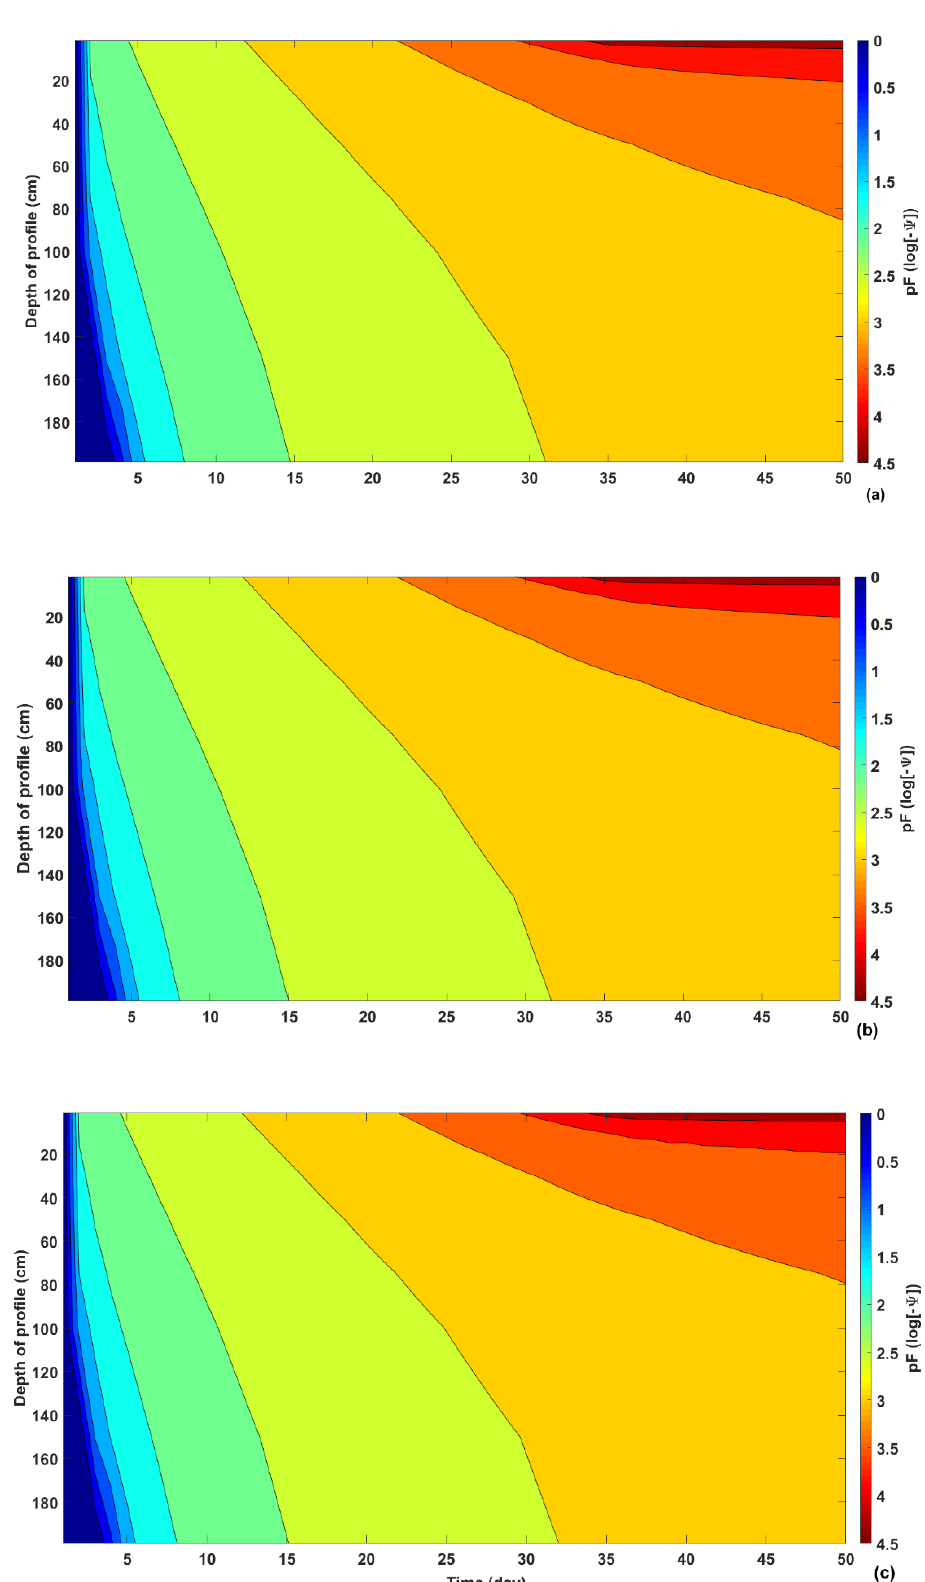
Figure 6. The simulated water potentials of the bauxite residue in a storage facility with initial water potentials of ( a ) − 1 kPa, ( b ) − 2 kPa and ( c ) − 10 kPa when exposed to an intense rainfall event (300 mm rainfall event). Ψ : water potential (hPa).